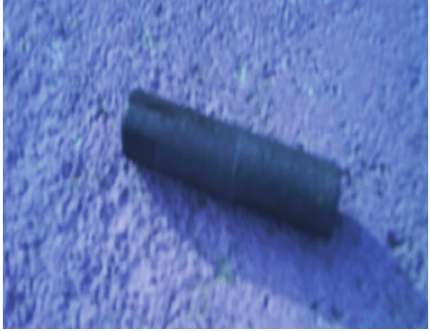
Figure 8: Pin for